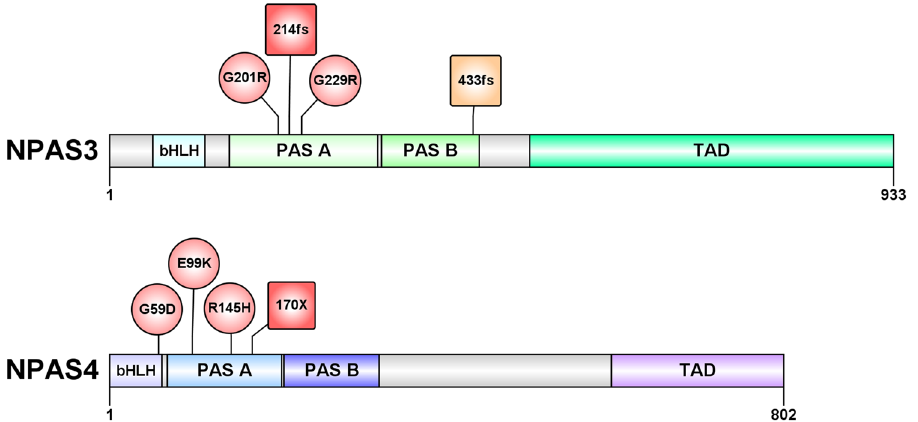
Figure 1. NPAS3 and NPAS4 variants characterised. Variants that were identified through exome sequencing in patients with intellectual disability or developmental delay are indicated in red. A mutation that was characterised but not found in a patient (NPAS3 433fs) is indicated in orange. Missense variants are labelled by circular boxes and truncating mutations are in square boxes. N-terminal domain boundaries were determined based on alignments performed for the NPAS1/NPAS3 crystal structure 51 . bHLH —basic Helix–Loop–Helix, PAS —Per Arnt Sim, TAD —trans-activation domain, NPAS3 —neuronal PAS 3, NPAS4 —neuronal PAS 4, fs — frameshift variant, X —nonsense variant.